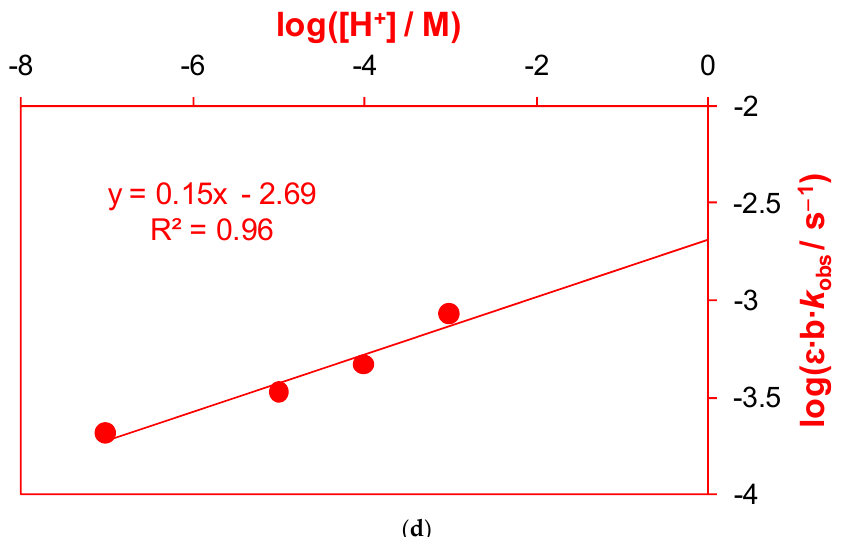
Figure 8. ( a ) Proton catalyzing effect on the rate constant in 10% v / v dioxane-water at 288 ± 0.5 K. ( b ) Proton catalyzing effect on the rate constant (log-log plot) in 10% v / v dioxane-water at 288 ± 0.5 K. ( c ) Proton catalyzing effect on the rate constant in 20% v / v dioxane-water at 285 ± 0.5 K. ( d ) Proton catalyzing effect on the rate constant (log-log plot) in 20% v / v dioxane-water at 285 ± 0.5 K. For further rectification of the results, the effect of ionic strength on the observed zero-order rate constant was studied in both 10–20% binary solvent media. We proposed iodide as the reactive species that controls the rate-determining step and leads the reac- tion mechanism. As a result, according to the formulation of the transition state theory (Equation (40)), our results should produce a linear fit with a negative slope. For greater ionic strength values, Equation (40) is employed, where A is the Debye-Hückel constant. Its mathematical value is determined by the solvent/media’s composition and dielectric constant as well as temperature. The dielectric constant is lowered in 10–20% reaction media, and a robust hydrogen bonding network is generated. As a result, the ionic strength we utilized for the uncatalyzed reaction becomes strong in both binary solvent media, making Equation (27) ineffective. Equation (40) is used when the ionic strength is high.